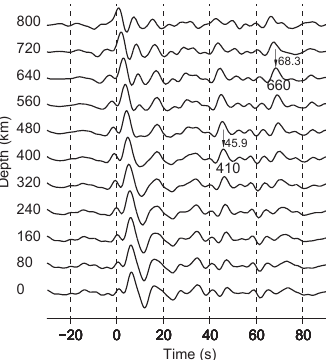
Figure 3. Stacked PRFs for the box with the corners at 38–40 ◦ N and 80–82 ◦ E. Move-out corrections for stacking are calculated for depth (in km) attached to the traces on the left-hand side. The de- tected P410s and P660s phases are marked by arrows. Note that the largest amplitudes of the P410s and P660s phases are observed at appropriate trial depths (around 400–500 and 600–700km, respec- tively).